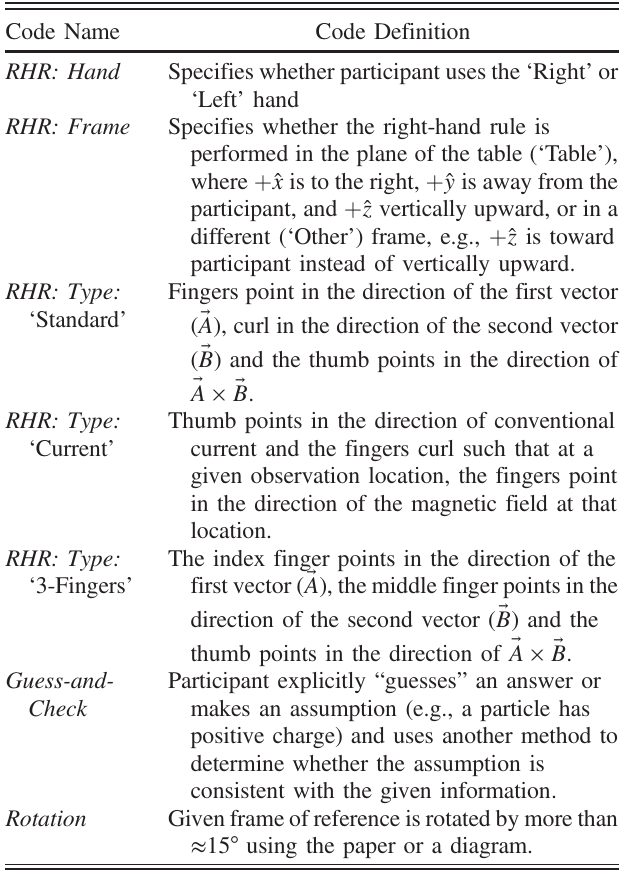
TABLE V. Brief definitions for methods discussed in the text. Descriptions of all methods can be found in Table